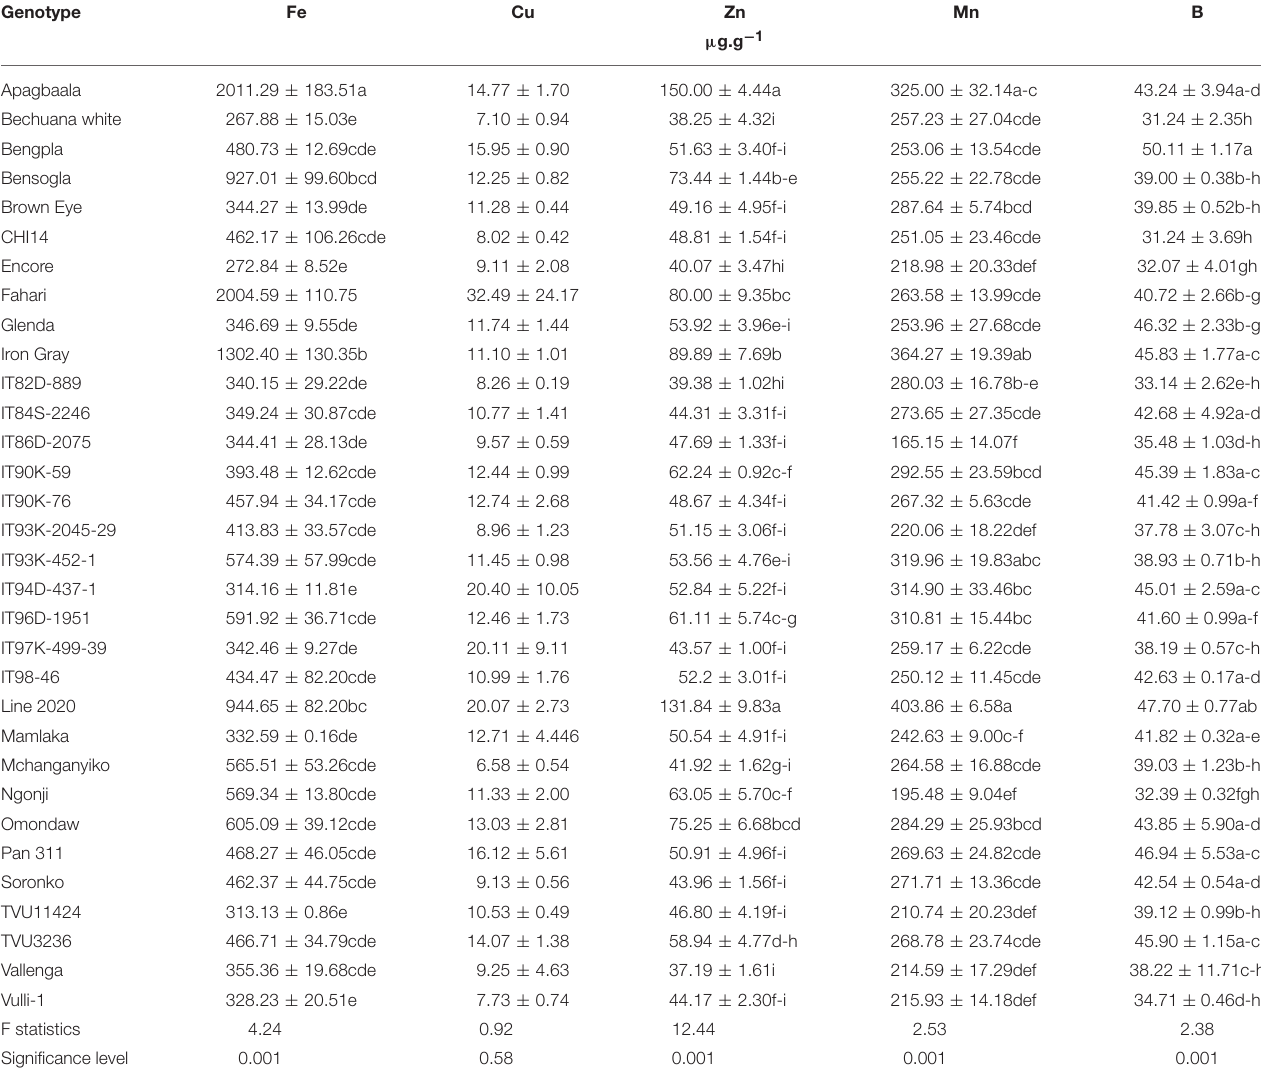
TABLE 1 | Micronutrients in edible leaves of field-grown cowpea varieties harvested at 76 DAP at Taung, South Africa in 2005.